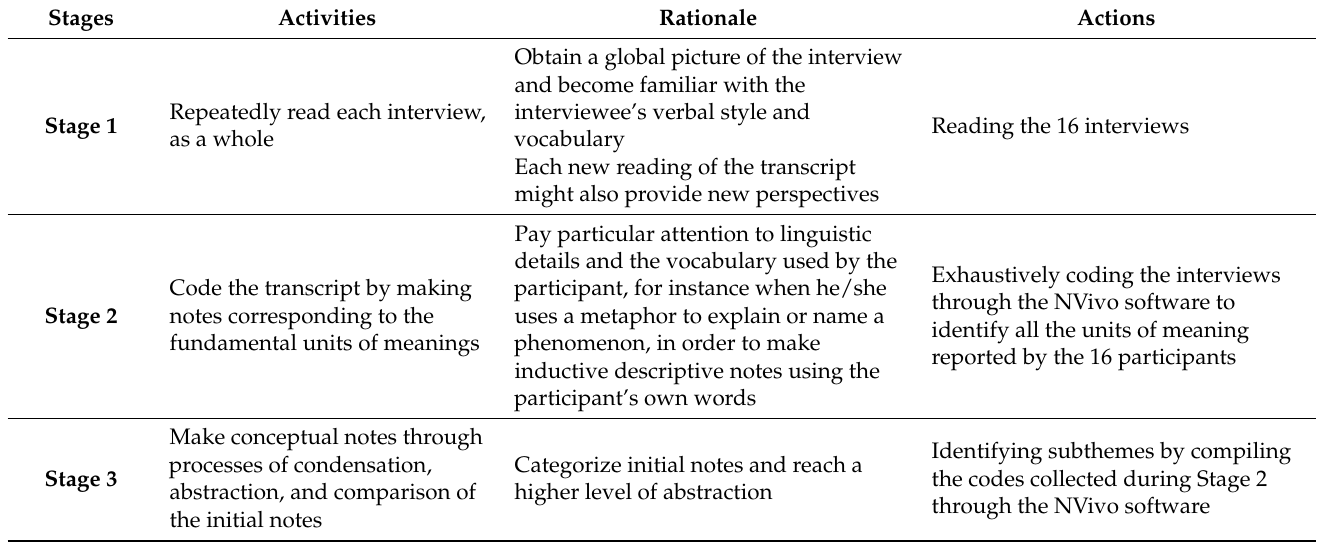
Table 1. Thematic analysis issued from Sibeoni et al.